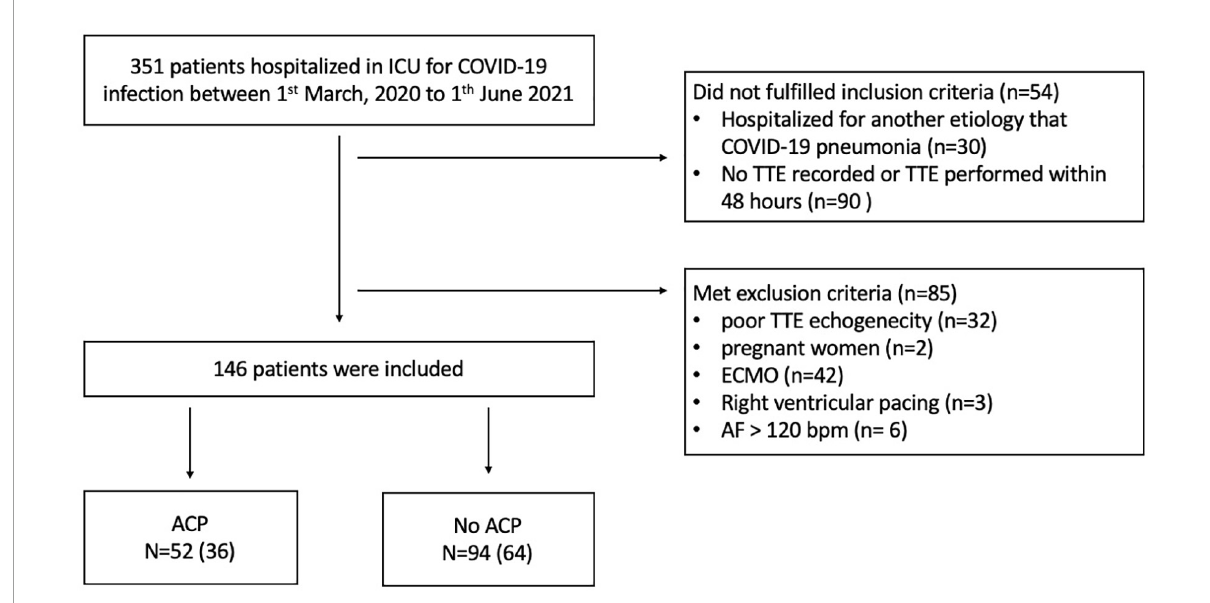
FIGURE1 Flow diagram of the study group. ACP, acute cor pulmonale; AF, atrial fibrillation; ECMO, extracorporeal membrane oxygenation; ICU, intensive care unit; TTE, transthoracic echocardiography.